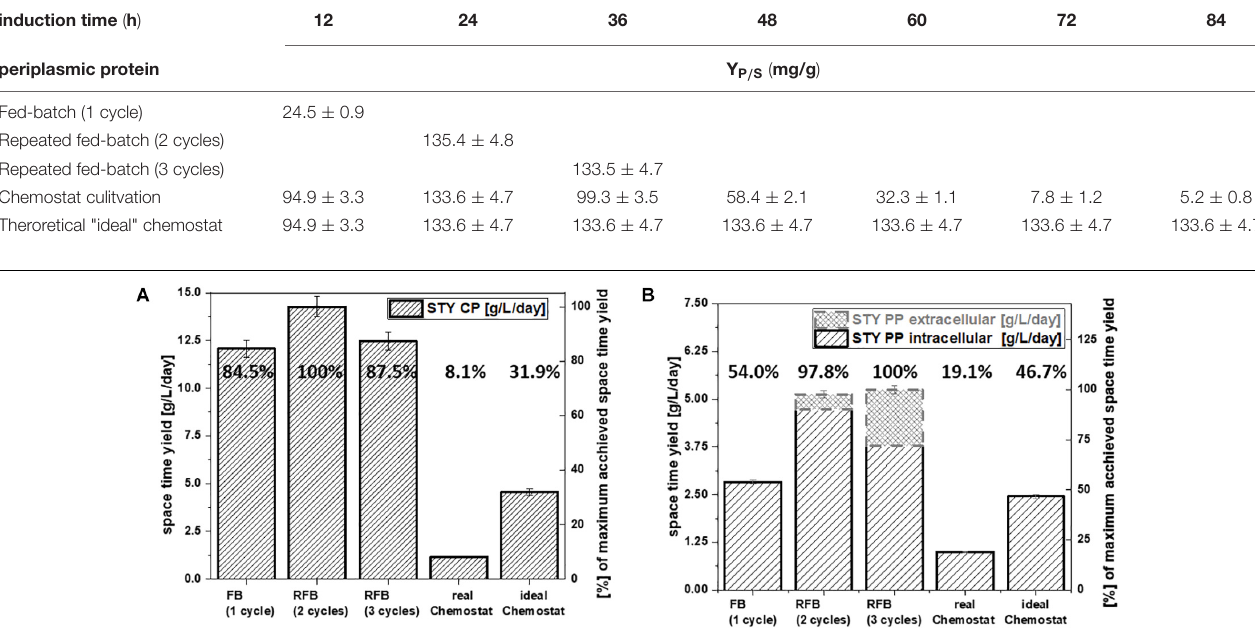
TABLE 5 | Comparing substrate per product yield in mg/g for the production of a periplasmic protein; each cycle is investigated separately for fed-batch and repeated fed-batch cultivation; chemostat cultivation is calculated as a rate every 12 h (i.e., one cycle).